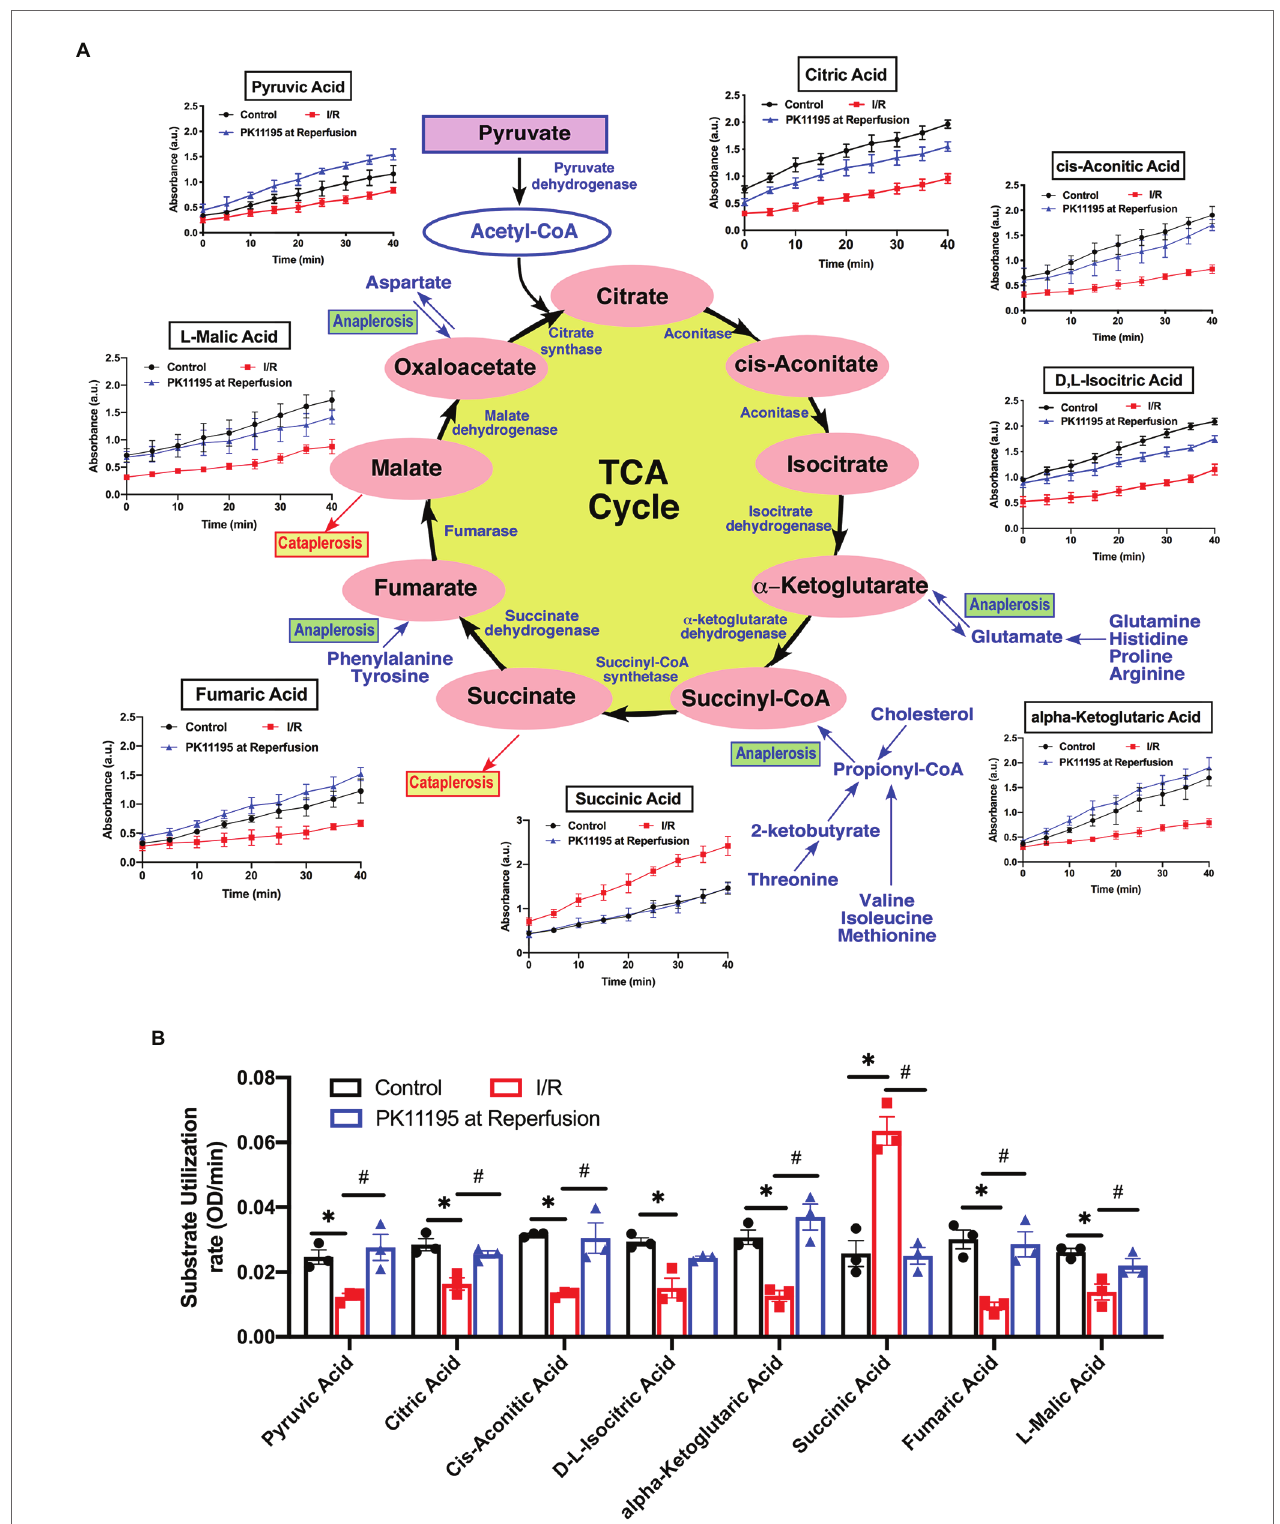
FIGURE 6 | Changes in Krebs (TCA) cycle substrate utilization in untreated rabbit cardiac myocytes, and cardiomyocytes exposed to simulated I/R in the absence or presence of 50 μ M PK11195. (A) Schematic representation of the intermediates in TCA cycle with the changes in intermediates utilization measured in the